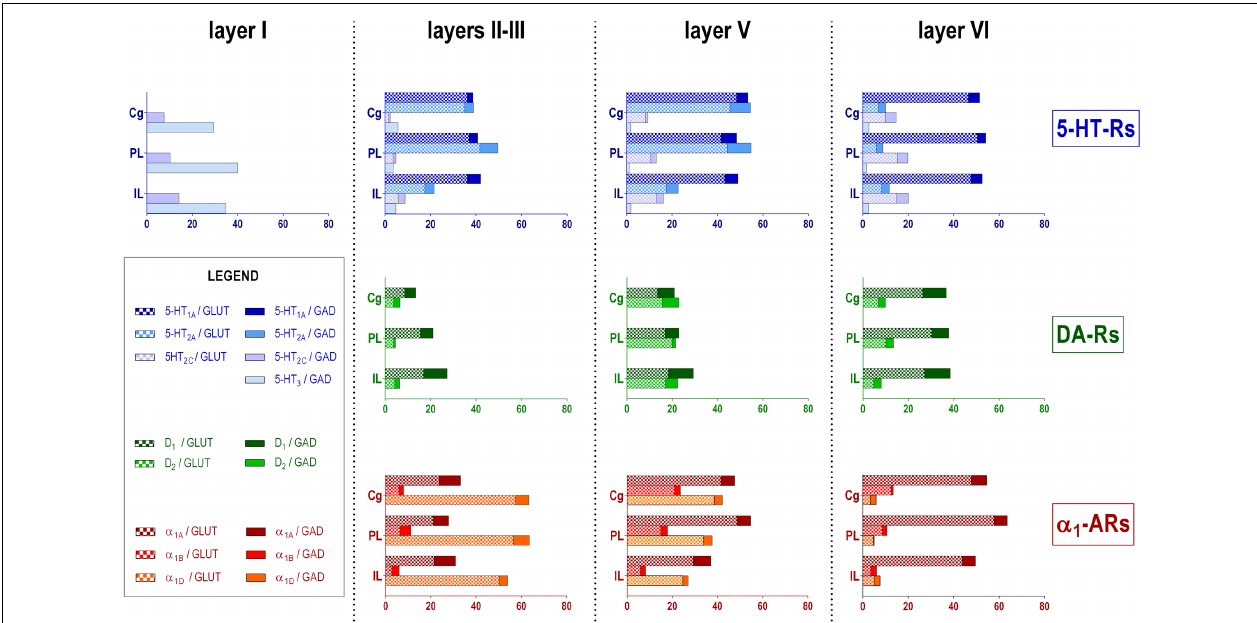
FIGURE 3 | Bar graphs showing the expression of each monoamine receptor mRNA in the different layers and PFC subfields of the mPFC. Data (mean of 3 rats, 2–3 consecutive sections per rat) are the percentages of pyramidal (VGLUT1-positive) or GABAergic (GAD-positive) neurons expressing each mRNA, expressed as percentages of the total neuronal population, assuming a standard 80% of pyramidal neurons and 20% of GABAergic interneurons. As layer I lacks glutamatergic neurons, layer I data is expressed as percentages of GAD-positive cells containing each receptor mRNA. Cg, anterior cingulate cortex; PL, prelimbic cortex; IL infralimbic cortex. Layer I, II–III, V, and VI stand for medial prefrontal cortical layers I to VI,